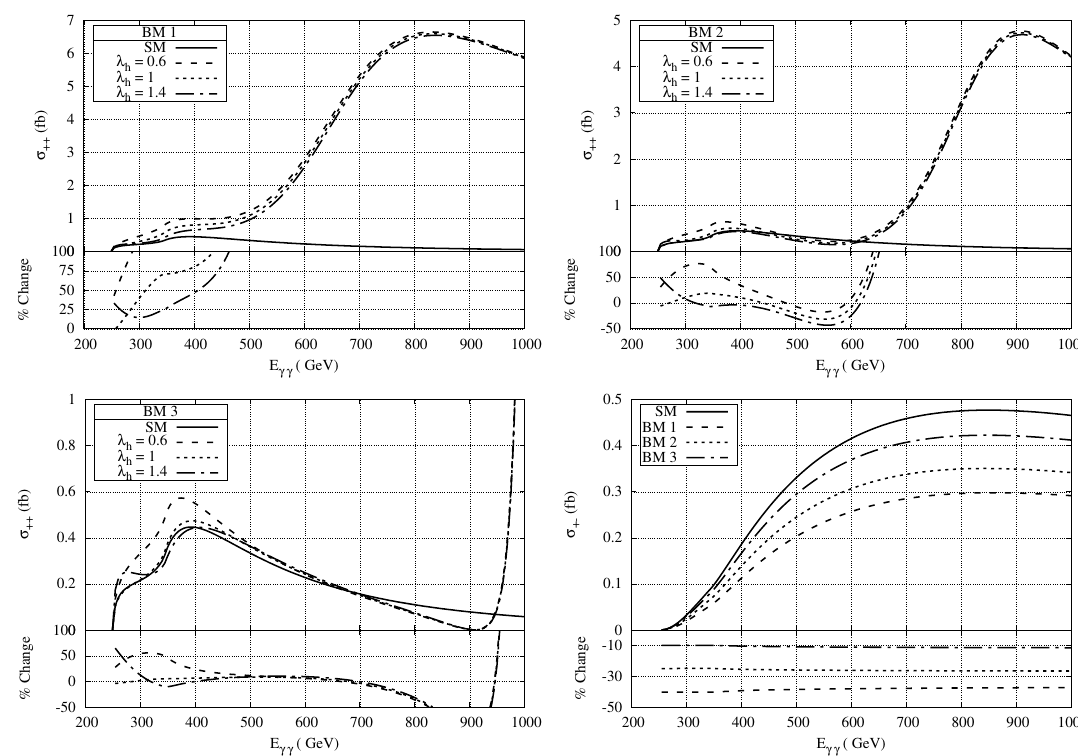
Figure 8 . γγ → hh helicity cross-section in the model with an additional heavy scalar H . The benchmark points (BM) for the above results are given in table